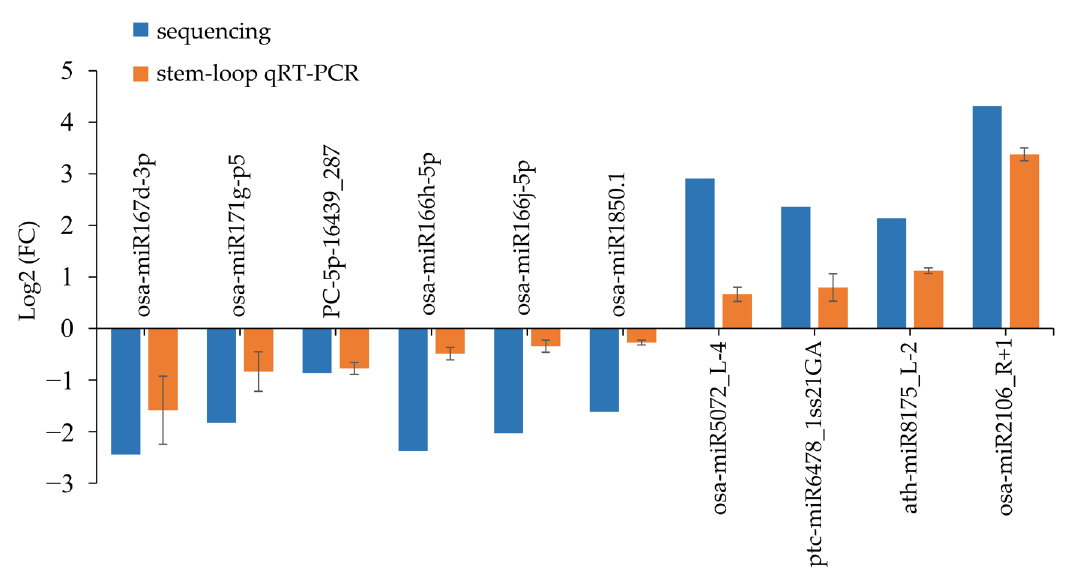
Figure 3. qRT-PCR validation of ten randomly selected salt stress-responsive miRNAs’ relative expression (fold changes of sequencing reads and qRT-PCR) between control and salt-treated library. The blue bars represent the fold change (log2) in control libraries relative to that in salt-treated libraries detected by small RNA sequencing, while the orange bars represent the fold change (log2) in control libraries relative to that in salt-treated libraries detected by stem-loop qRT-PCR (normalized to U6snRNA; n = 3).